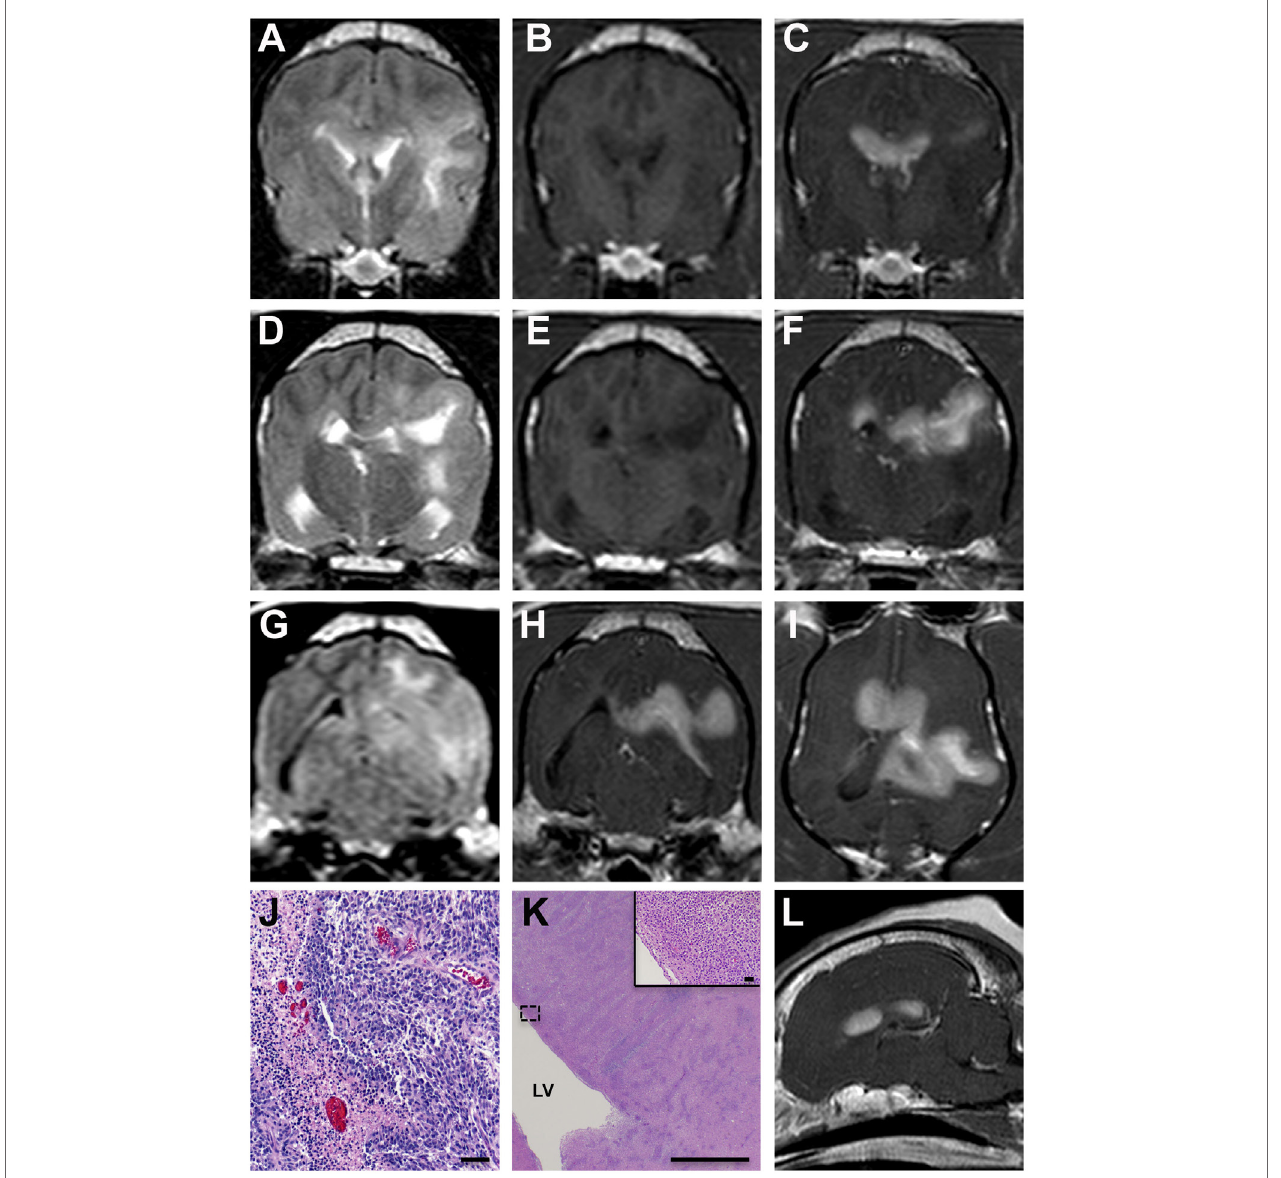
FIGURe 2 | MRI and pathological features of asymmetrical butterfly glioblastoma, Case 1 . Transverse T2 (a,D) , T1 (B,e) , FLAIR (G) , and post-contrast T1 (C,F,H) MR images from the rostral aspect of the intra-axial mass at the level of the cruciate gyrus (a–C) , the midportion of the lesion (D–F) , and caudal aspects of the mass at the level of the mesencephalic aqueduct (G,H) . The mass is T1 hypo- to isointense, T2/FLAIR hyperintense and demonstrates marked contrast enhancement. Mass effect, manifest as left lateral ventricular compression and a falx shift to the right, and T2/FLAIR hyperintensity in the perilesional white matter are evident. The extensive corpus callosal and bihemispheric involvement of the contrast-enhancing lesion burden is depicted in the T1 post-contrast dorsal planar (I) , transverse (C,F,H) , and parasagittal images (L) . Microscopic features of GBM (J) include serpentine necrosis, glial pseudopalisading, and microvascular proliferation, H&E stain, bar = 125 μ m. Diffuse neoplastic infiltration of the periventricular white matter [ (K) ; LV, right lateral ventricle; bar = 3.5 mm] of the right cerebrum, H&E stain, bar = 40 μ m,